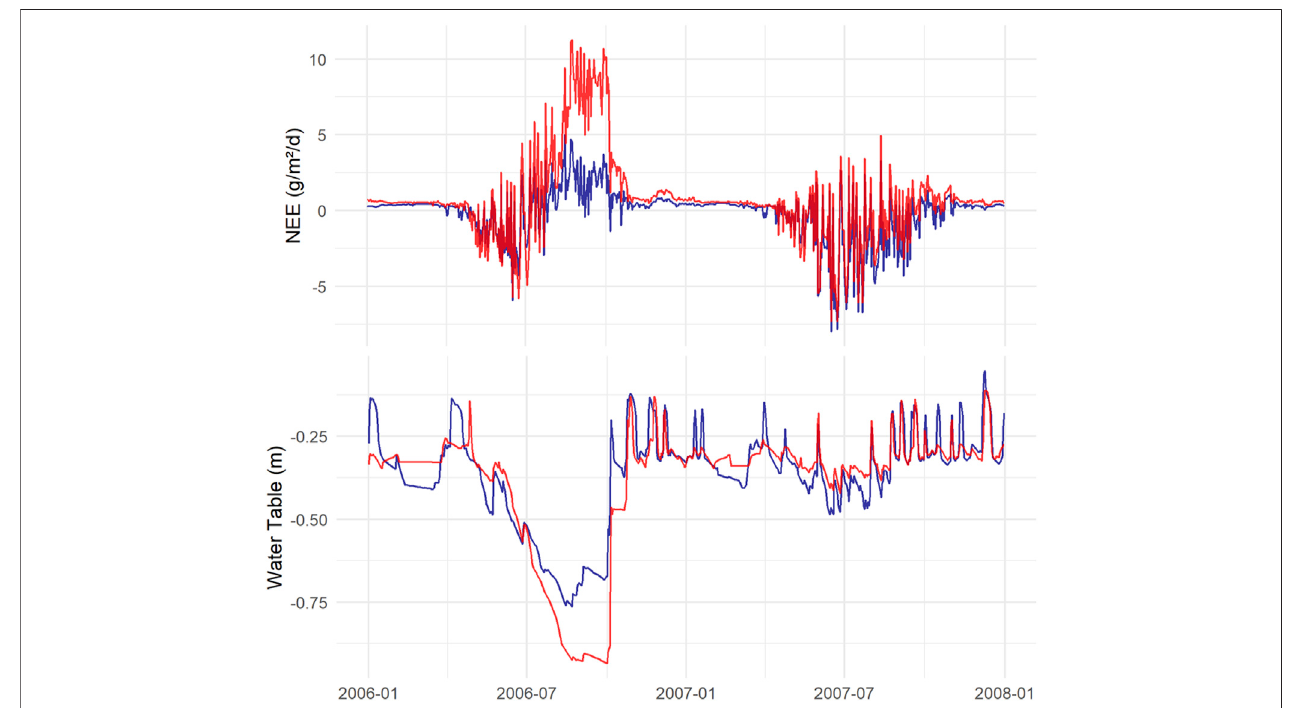
FIGURE10| SimulatedNEE,whereanegativenumbershowsuptake,andWT fl uctuationsduringthedryyear2006andthefollowingmorenormalyear2007,forK (blue) and L (red).